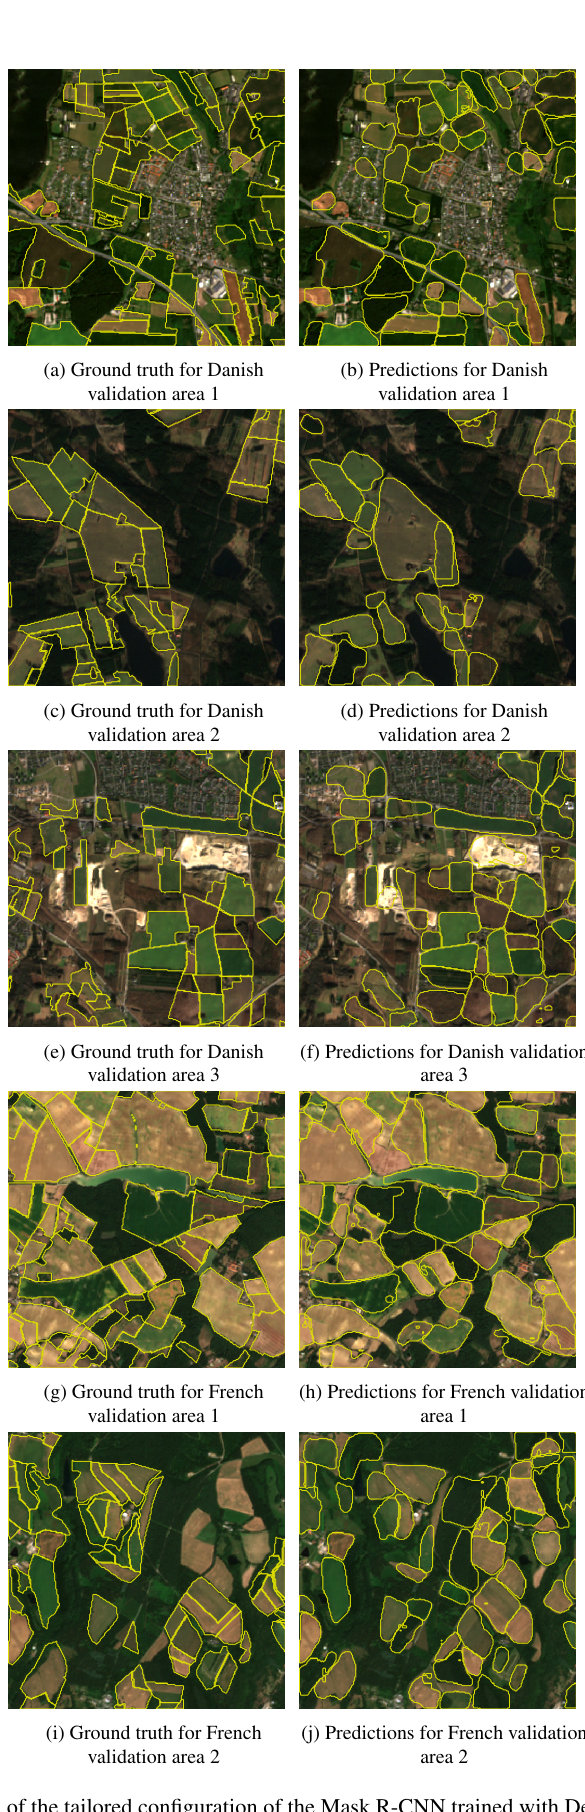
Figure 4. Example of predictions of the tailored configuration of the Mask R-CNN trained with Denmark dataset over few validation areas from France and Denmark. Field boundaries are highlighted in